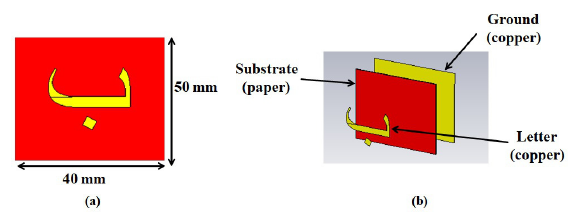
Figure 1. Design of Arabic letter (cid:72)(cid:46) (baa) tag: ( a ) Tag dimensions; ( b ) Structure of the